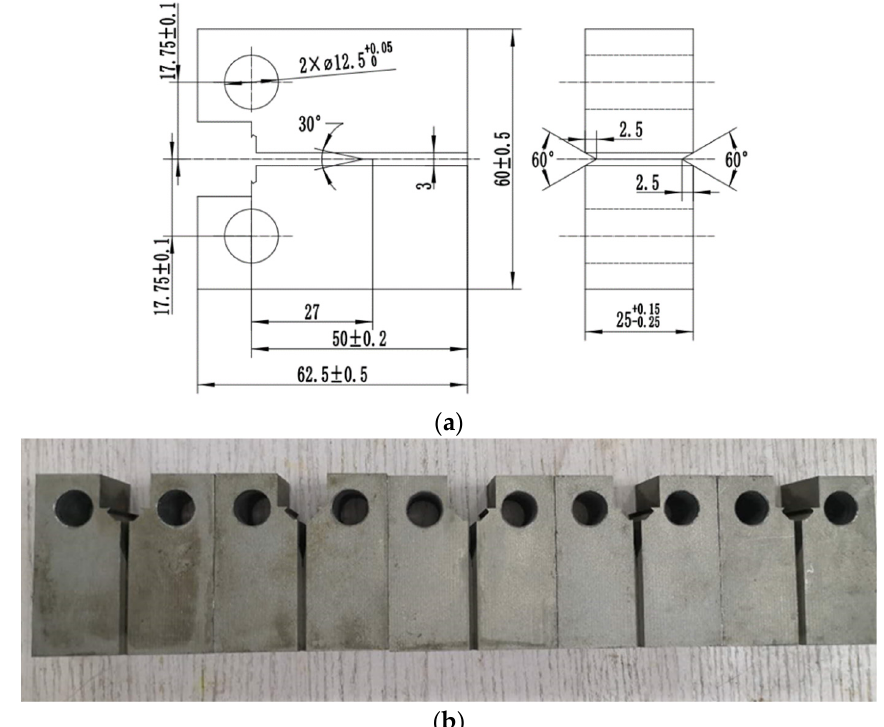
Figure 8. 1T-CT sample. ( a ) 1T-CT sample design parameters. ( b ) 1T-CT real sample. The fracture toughness test was carried out on an Instron 8850 test machine (Instron Corporation, Canton, OH, USA) with a cryostat cooled by liquid nitrogen, as shown in Figure 9. The test temperature ranges from − 100 ◦ C to 20 ◦ C, with one temperature point set every 20 ◦ C. Before the experiment, the sample was cooled for 30 min, so that the sample was fully cooled. The test results at different temperatures are shown in Figure 10.